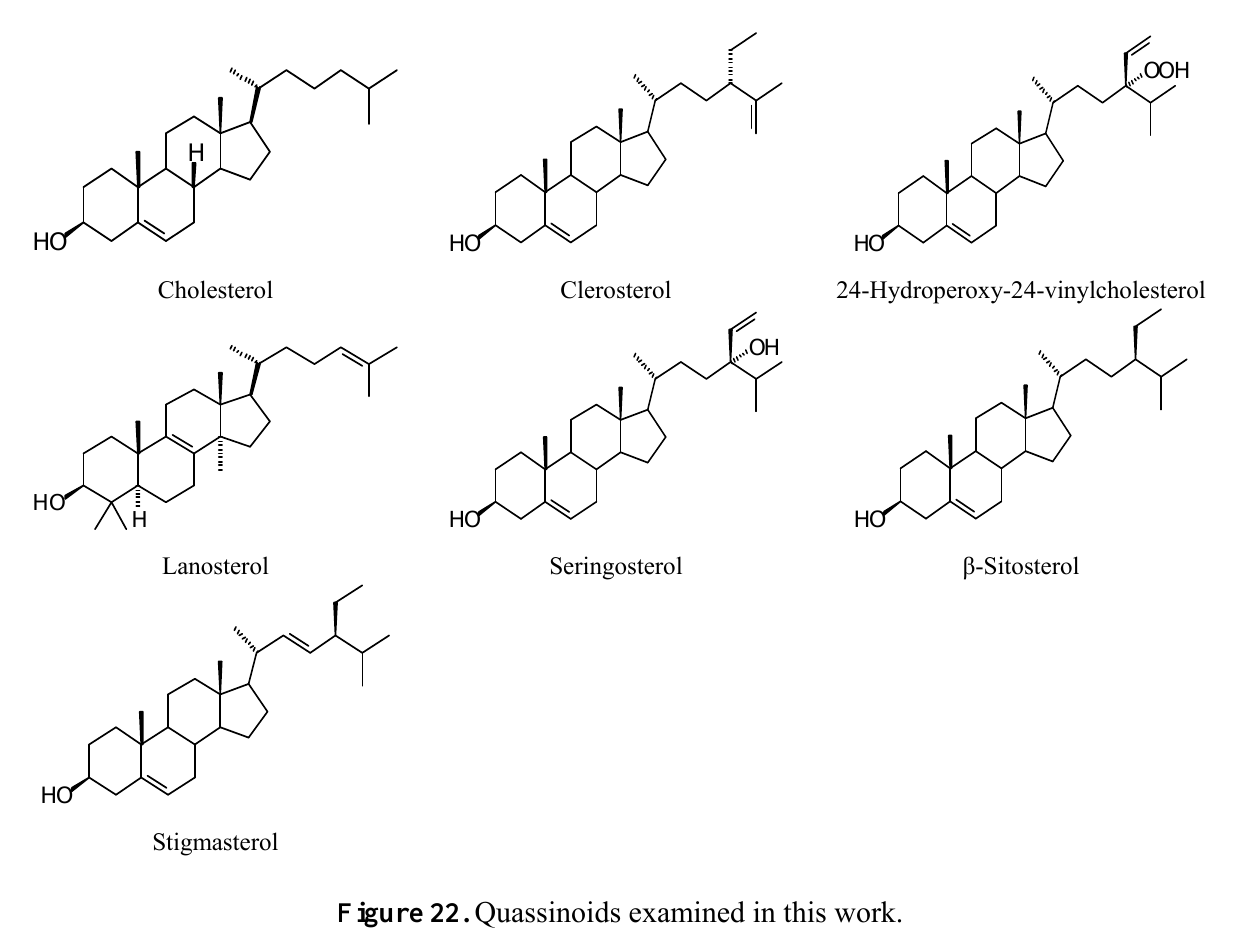
Figure 21. Steroids examined in this work.